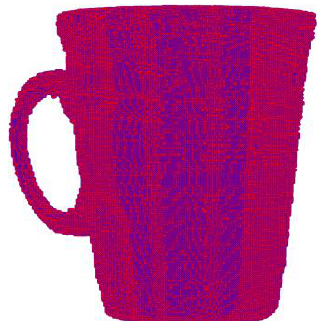
Figure 12 . Final reconstructed model (second